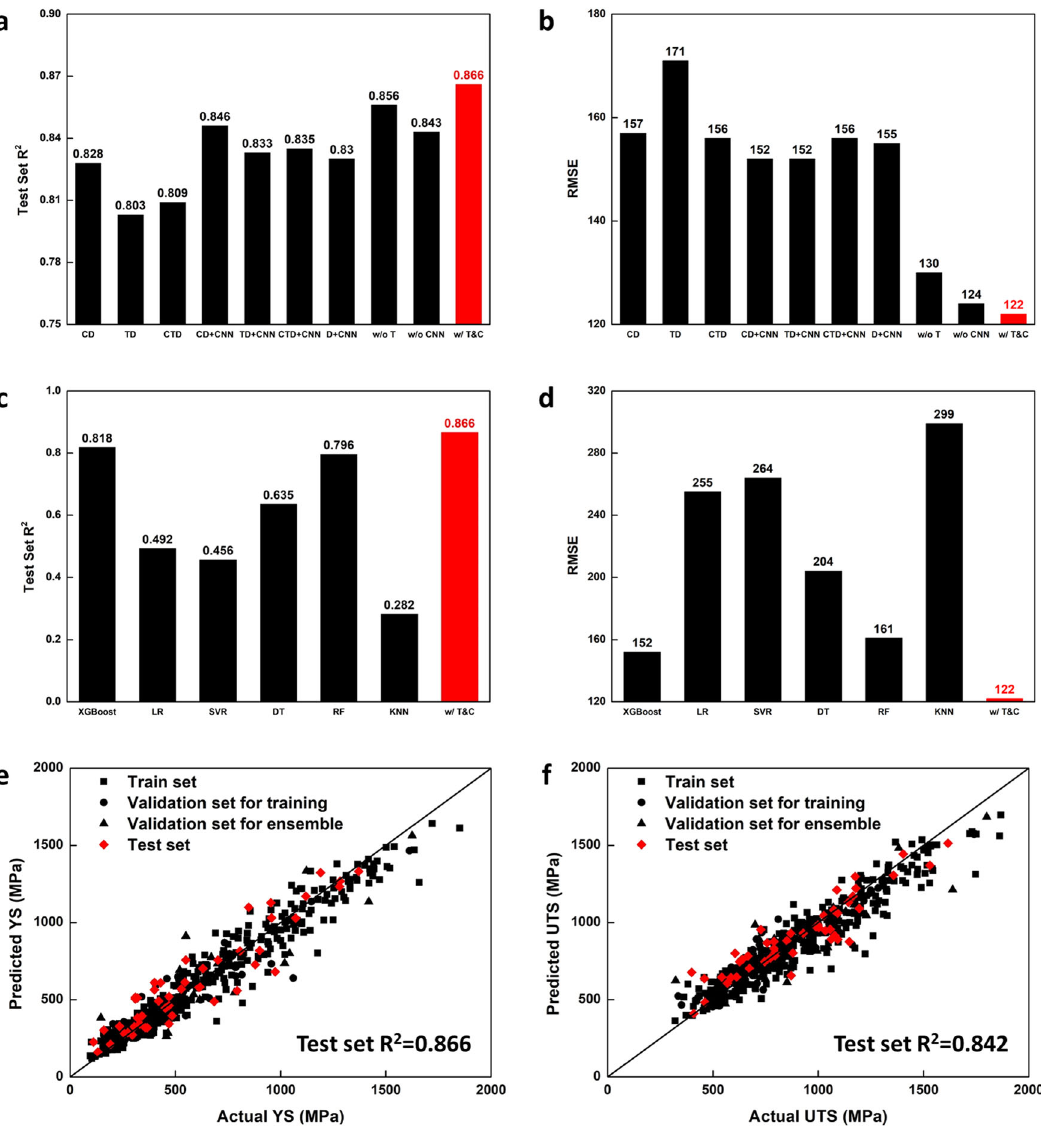
Fig. 1 Averaged coef fi cients of determination (R 2 ) and root mean square errors (RMSE) of the machine learning models and comparison of predicted and actual data of the present model. a R 2 and ( b ) RMSE comparison of neural network models and the present model (w/ T&C). c R 2 and ( d ) RMSE comparison of machine learning models other than neural network models and the present model. e The comparison plot for YS data. f The comparison plot for UTS